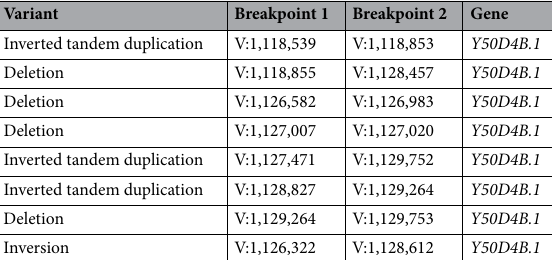
Table 1. Breakpoints of the complex rearrangement present in eT1 containing strains on